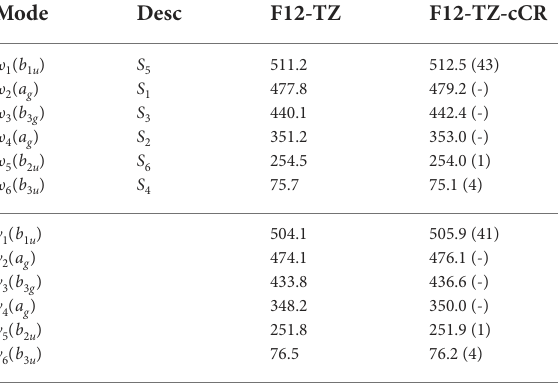
TABLE 9 Harmonic ( ω ) and Fundamental ( ν ) Vibrational Frequencies (in cm −1 ) with Intensities (in km mol −1 , in Parentheses) for r -Si 4 . Mode descriptions (Desc.) refer to the SICs in Eqns. 1-24.